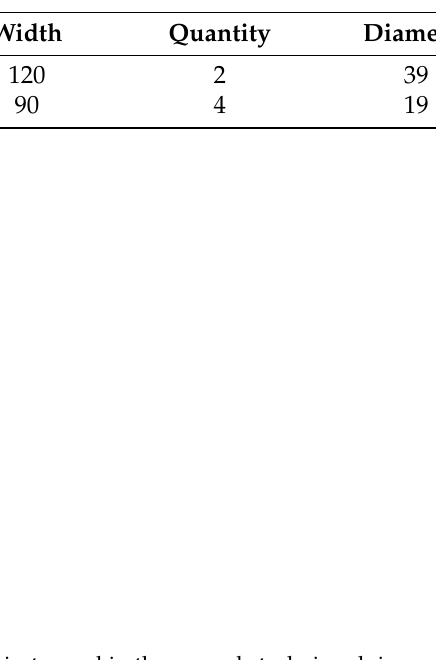
Figure 8. A sample optimal solution for the objects used in the second study involving rotational degrees of freedom. The filling ratio for this packing configuration is